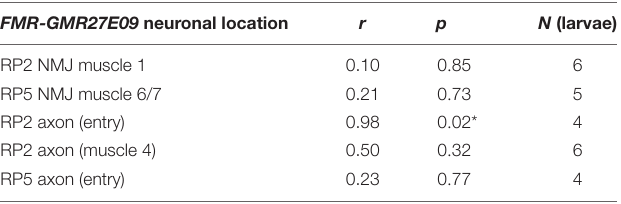
TABLE 2 | Correlation analysis of peak (cid:49) F / F between ER lumen and cytosol in NMJ and axons using Pearson’s correlation coefficient. FMR-GMR27E09 neuronal location r